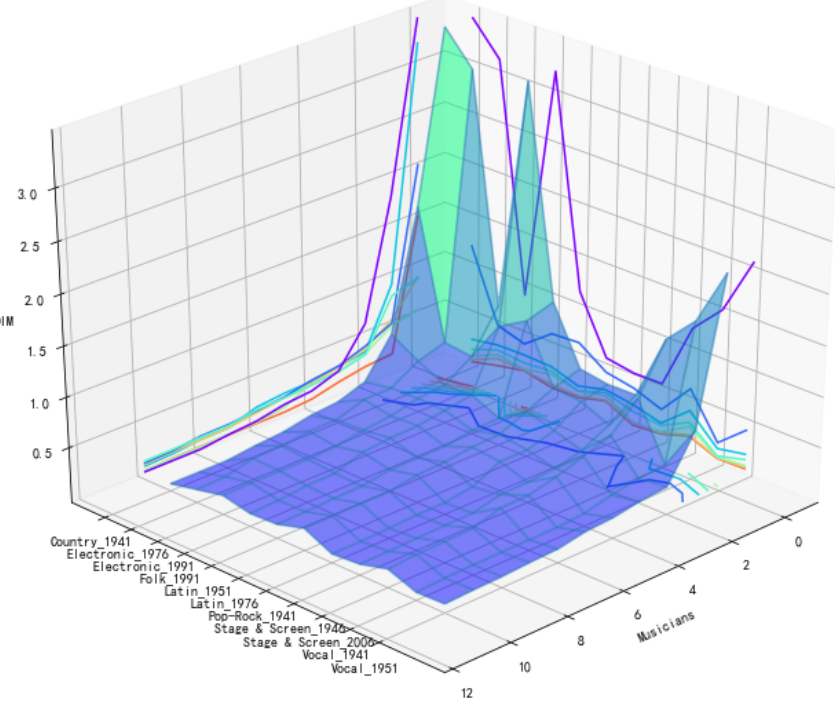
Figure 11. DMI of revolutionary artists of different